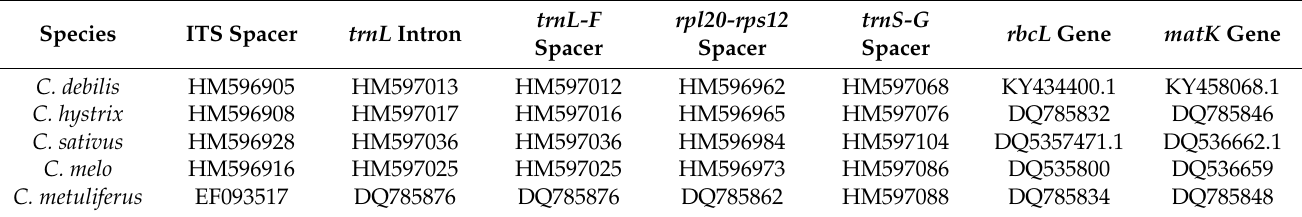
Table 2. Accession numbers of ITS nuclear and chloroplast sequences used in this